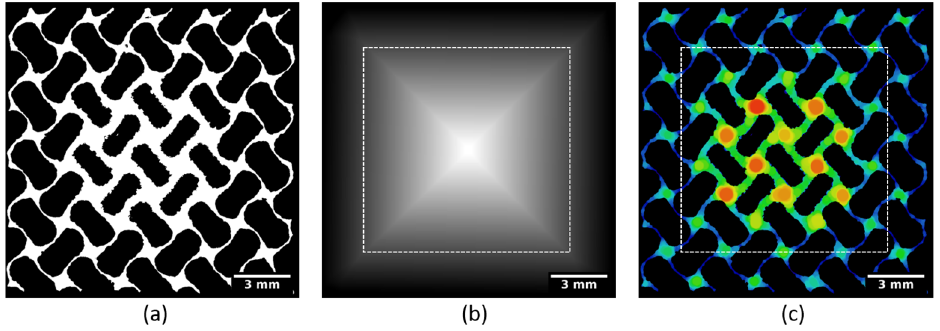
Figure 7. Schematic workflow generated for WT analysis of the gradient structures. ( a ) A binarized 2D slice of the 2 × 06 specimen after CE; ( b ) the Euclidean distance map; ( c ) the result of the WT analysis. The white square indicates one set of voxels having the same distance from the closest